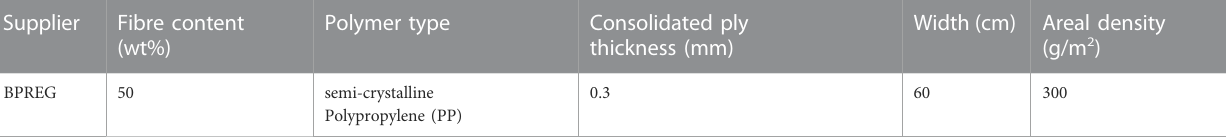
TABLE 2 The technical speci fi cations of the Flax/Polypropylene (PP) commingled unidirectional fabric (BPREG,